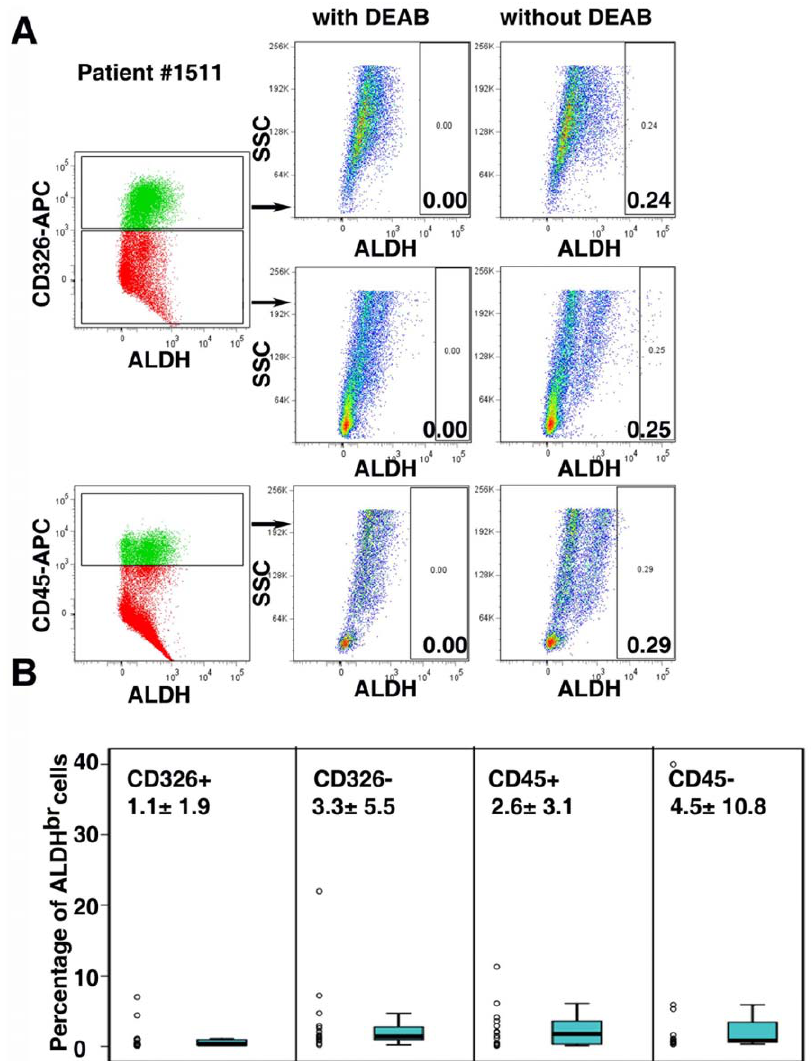
Figure 4. ALDH1 enzymatic activity in primary epithelial ovarian cancer cells. A . ALDH1 enzymatic activity in cells isolated from one ovarian cancer specimen. Dead cells were eliminated using magnetic beads and a MidiMACS separator. For immunophenotyping of ALDH br ascites cells, APC-CD45 or APC-CD326 was used for counterstaining. DEAB was used to inhibit the reaction of ALDH with the ALDEFLUOR reagent, providing a negative control. B . Summary of the percentages of ALDH br in each cell population from 16 late-stage ovarian cancer